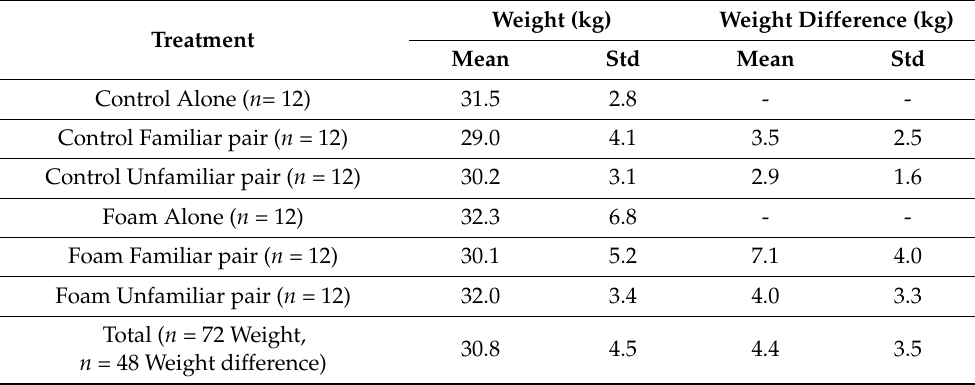
Table 1. Pig body weights and weight differences between pairs of pigs within the treatments (Control Alone, Control Familiar pair, Control Unfamiliar pair, Foam Alone, Foam Familiar pair, and Foam Unfamiliar pair). Mean value and standard deviation